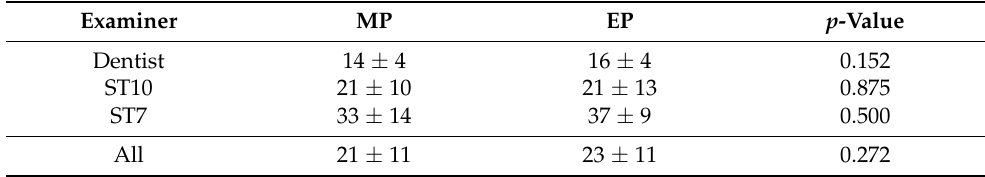
Table 4. Time needed for manual probing (MP) and electronic probing (EP) (in min) differentiated by level of examiner’s experience (dentist, 10th of 7th semester students, ST10,